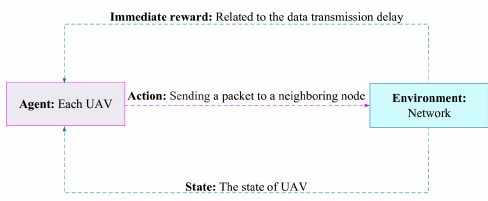
Figure 35. Learning process in PPMAC+RLSRP. Table 17. The most important advantages and disadvantages of